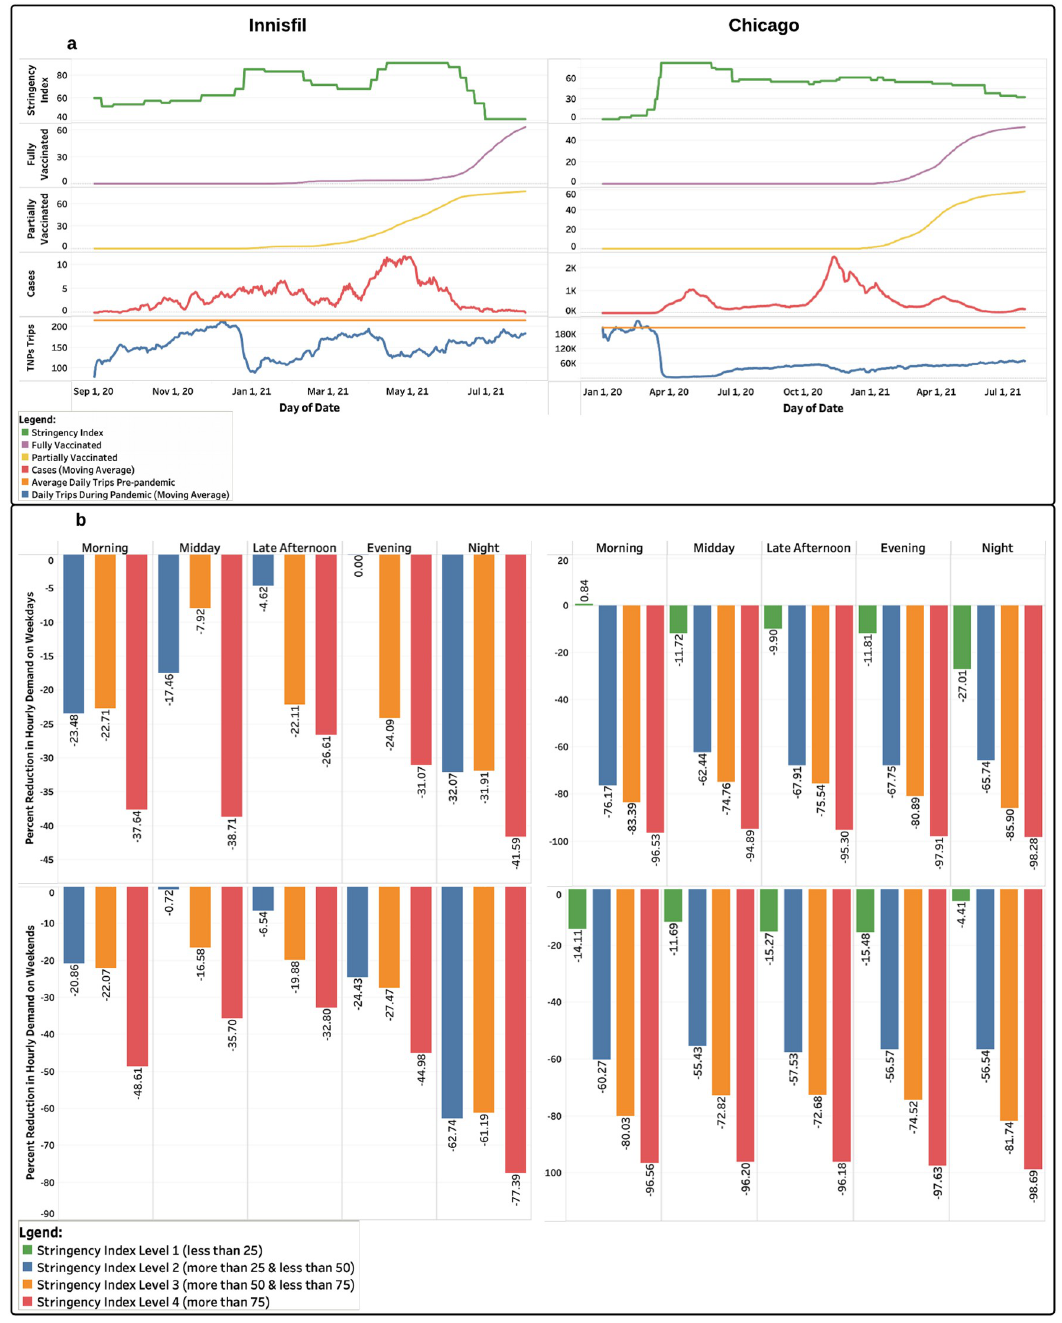
Fig 4. The impact of stringency index on the daily and hourly demand values in Innisfil and Chicago. (a) The relationship between the stringency index, vaccination rates, COVID-19 cases, and the daily trip demand in Innisfil and Chicago. (b) Effects of stringency index on weekdays and weekends hourly demand values in Innisfil and Chicago. To explore the impact of the stringency index on the hourly demand, we categorized its values into five levels: pre-pandemic (stringency index = 0), less than 25, 25–50, 50– 75, and more than